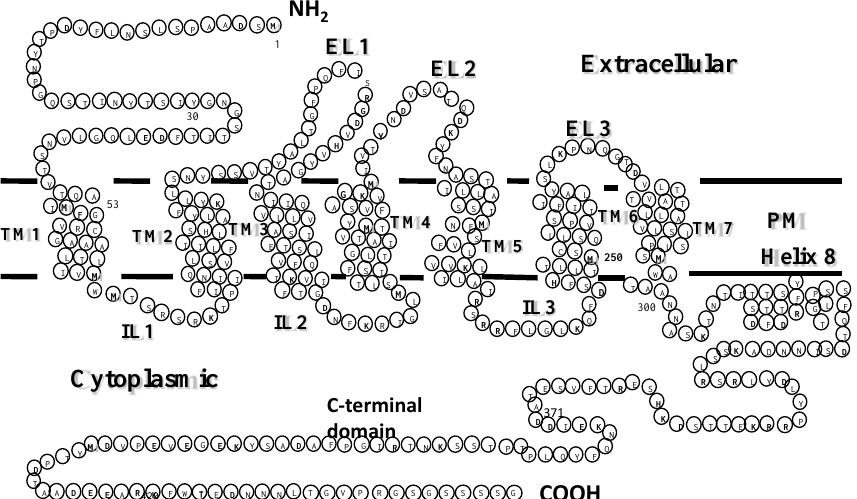
Figure 2. Snake diagram of Ste2p. A 2D representation of Ste2p showing the N-terminus, seven-transmembrane TM bundle, C-terminus (CT), and three extracellular (EL) and three intracellular (IL) loops that connect TMs to each other. The TMs are embedded in the plasma membrane (PM), with the N-terminus facing extracellularly and the C-terminus facing intracellularly. The presence of an 8th helix is indicated, as will be discussed later in the review.